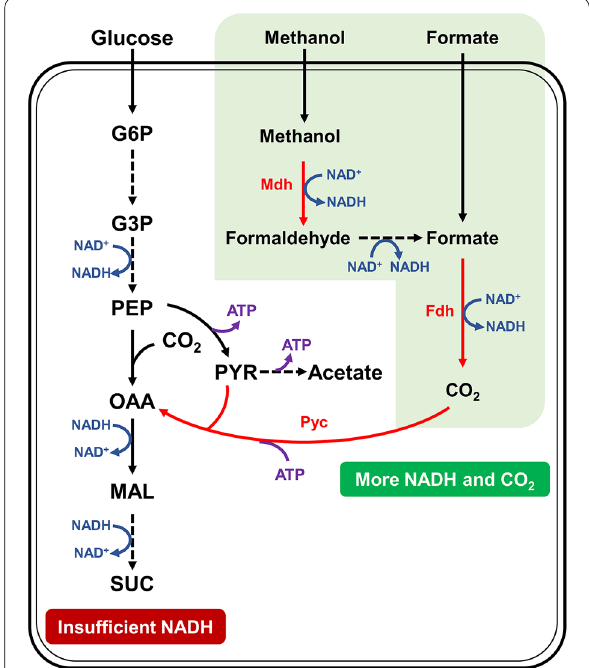
Fig. 1 Diagram showing the metabolic pathway of succinic acid of engineered E. coli under anaerobic condition. The dissimilation metabolic pathway of methanol and formate and a new pathway of fixing CO2 were introduced. G6P glucose-6-phosphate, G3P 3-phosphate-glyceraldehyde, PEP phosphoenolpyruvic acid, OAA oxaloacetate, PYC pyruvate, Mdh methanol dehydrogenase, Fdh formate dehydrogenase, Pyc pyruvate